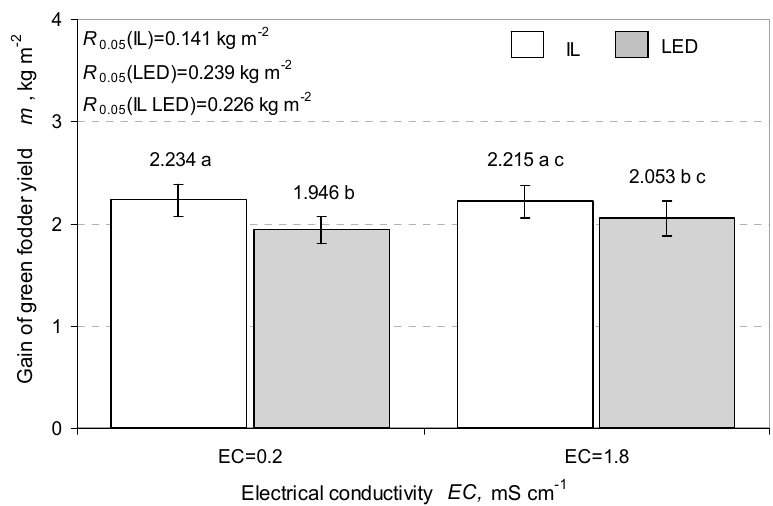
Figure 7. Influence of macro- and micronutrients on the growth of wheat fodder weight with indoor lighting or LED and a growing tray slope angle of 6.5%. Each vertical bar is 95% confidence interval. Any two samples with a common letter are not significantly different ( p < 0.05), as assessed using the least significant difference.